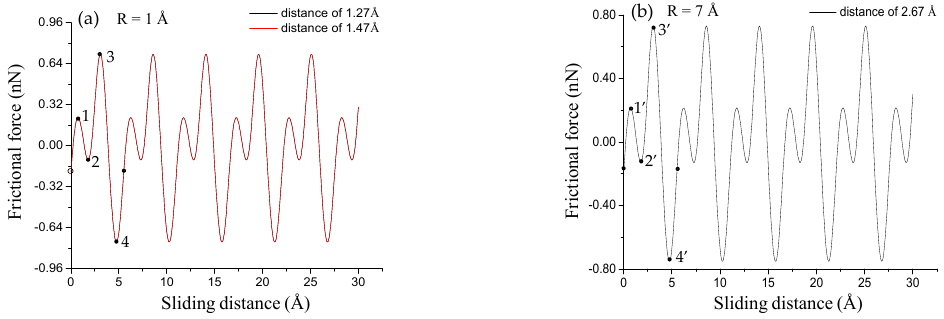
Figure 7. Frictional force–sliding distance curves for various vertical distances (1.27, 1.47 and 2.67 Å) between the tip and SLMoS 2 film for sliding paths along the AC orientation. The tip radii of 1 Å, and 7 Å are for ( a) and ( b) , respectively. All the frictional force–sliding distance curves for various vertical distances (1.27, 1.47, 1.67, 2.27, and 2.67 Å) between the tip and SLMoS 2 film for sliding paths along the AC orientation and ZZ orientation are shown in Figure S1 (Supplementary Materials).